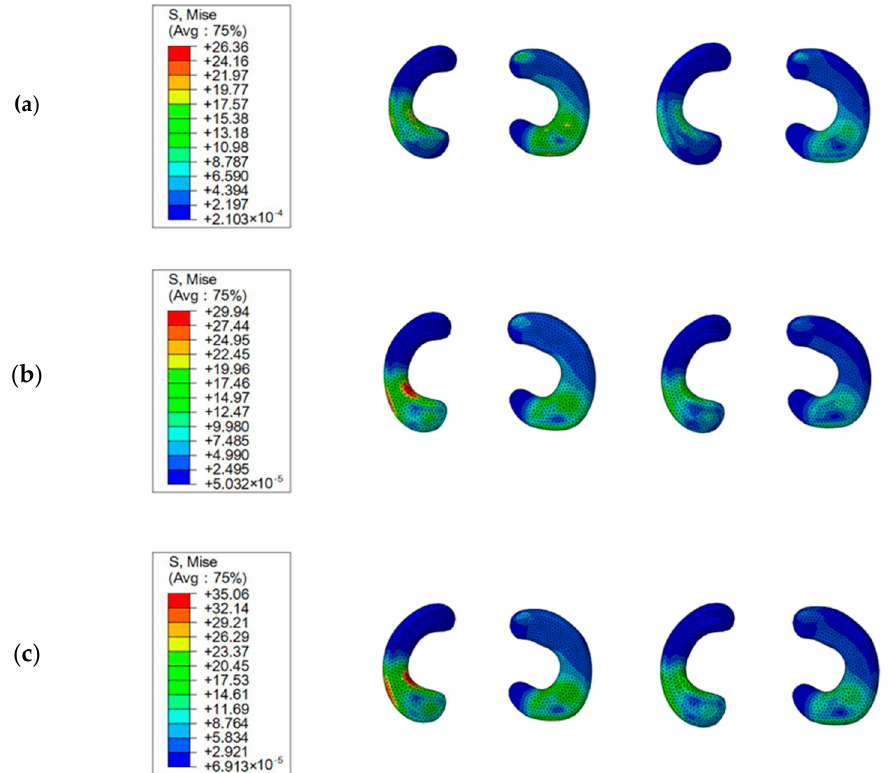
Figure 5. Von Mises stress distribution of the menisci in braced (right) and unbraced (left) conditions at ( a ) 0.4 m, ( b ) 0.8 m, and ( c ) 1.2 m.